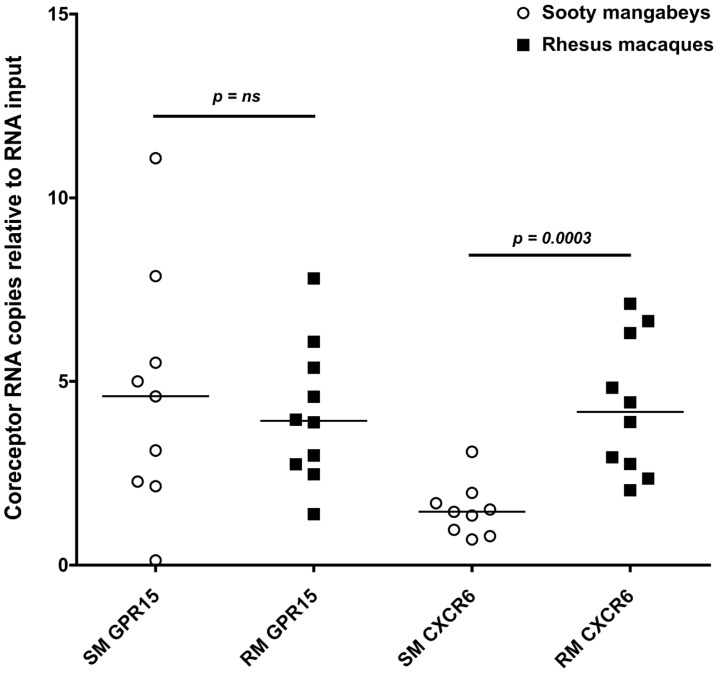
Alternative coreceptor expression in infants SMs and RMs.RNA expression of the alternative coreceptors GPR15 and CXCR6 was measured in sorted CD4+ T cells from infant SMs and RMs by real time PCR. CD4+ T cells were negatively selected by MACS microbeads and purity was assessed by flow cytometry (>80% for all animals). Mann Whitney test was used to assess significance.